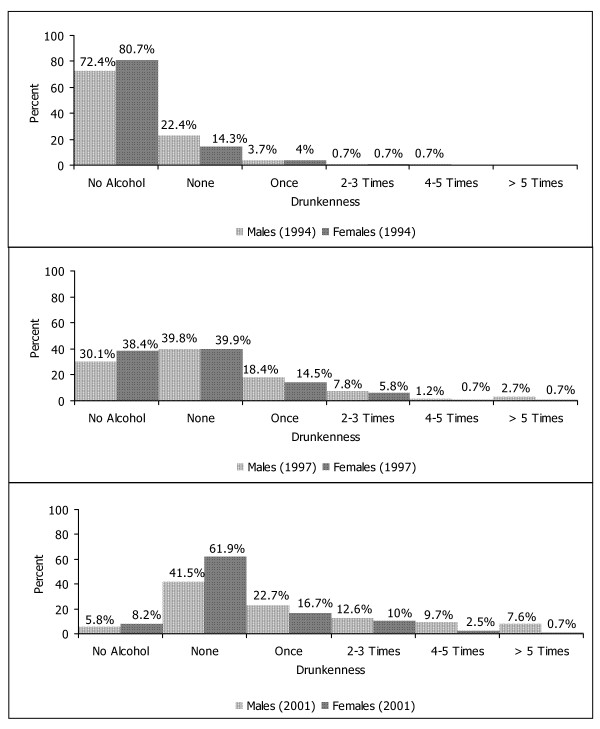
Frequencies of drunkenness during the last two months at three times.